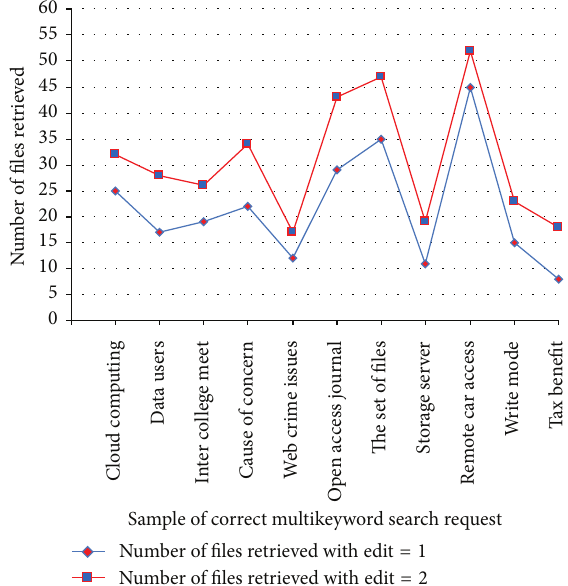
Figure 4: Data utilization efficiency for correct keywords in ACMFS.